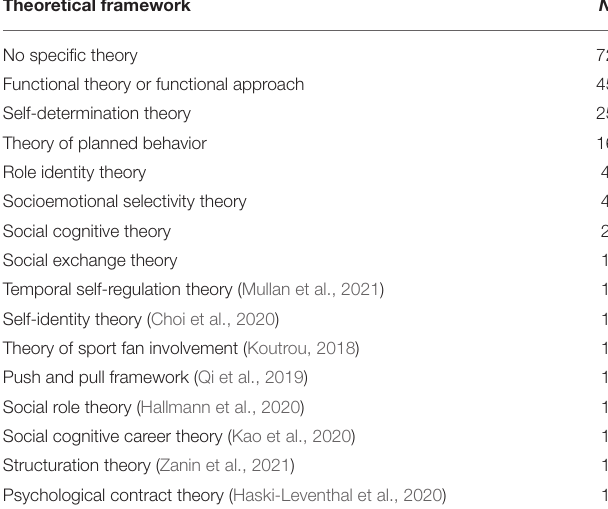
TABLE 3 | Theory used in the